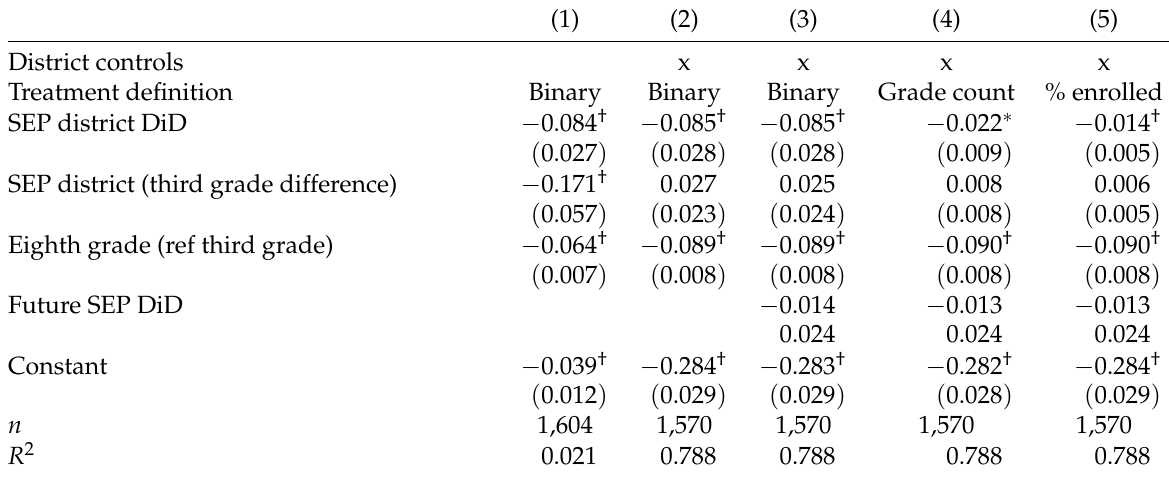
Table 3: OLS DiD regression of mean math achievement on SEP district